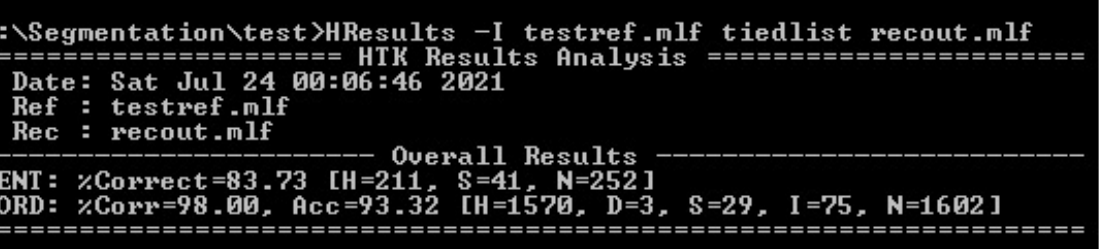
Figure 12. HTK results or Qur’anic Tajweed acoustic model.